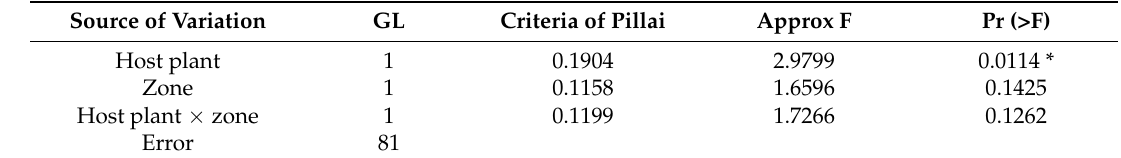
Table 5. Multivariate analysis of variance (MANOVA) in the metrics of female genitalia of N. elegantalis , collected in two hosts ( S. quitoense and S. betaceum ) and two Zones (Western Andes and Eastern Andes). Source of Variation GL Criteria of Pillai Approx F Pr